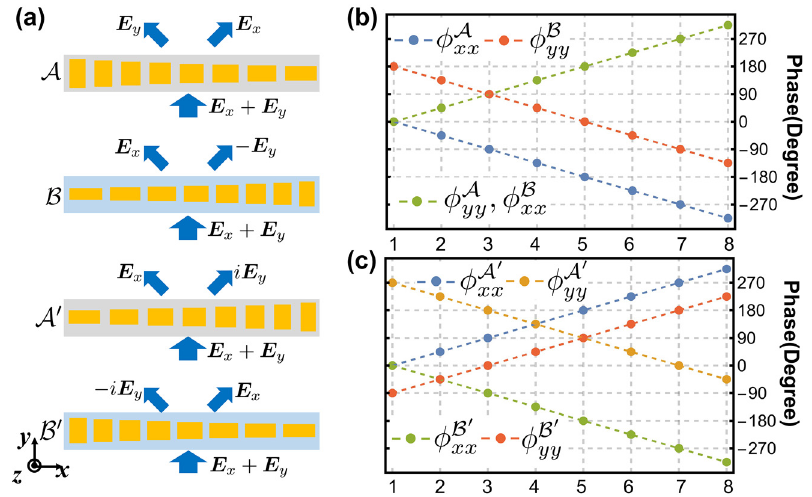
− E to x y − i E to x y